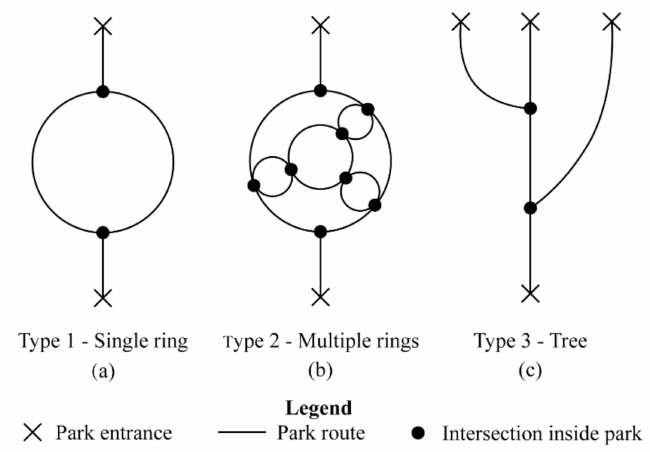
Figure 4. Road structure patterns of three parks. ( a ) is the single ring pattern; ( b ) is the multiple rings pattern; ( c ) is the tree pattern. Copyright 2020 © Author, all rights reserved, used by